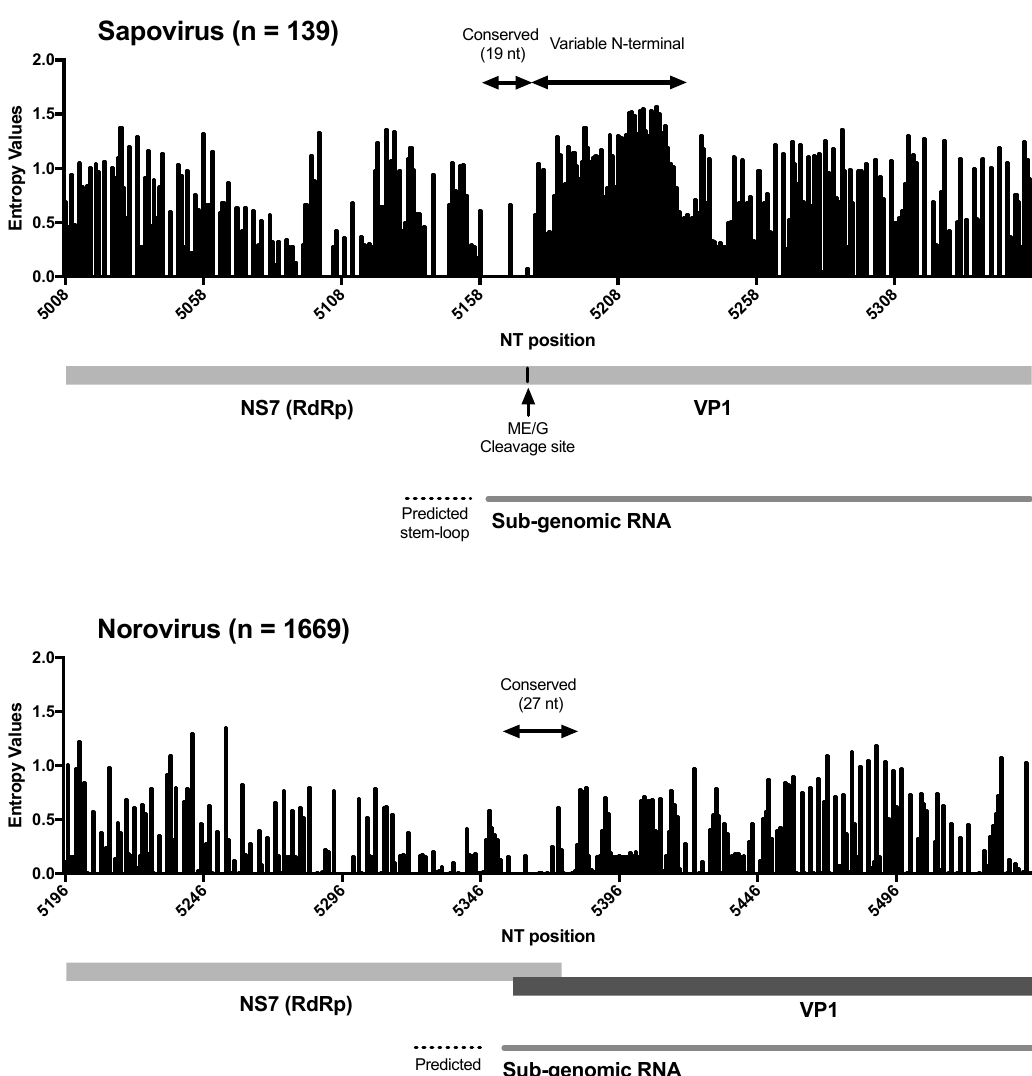
Figure 8. Variation at the RdRp-VP1 boundaries could explain limited recombination in human sapovirus. Shannon entropy values were calculated to quantify the nucleotide conservation for each site in the RdRp-VP1 boundaries. Sapovirus dataset includes human sapovirus GI, GII, GIV, and GV strains ( n = 139), and norovirus dataset includes human norovirus GI and GII strains ( n = 1669). Position of nucleotides was based on the multiple sequence alignments, including indels. Stem-loop sequences on predicted sub-genomic RNA promoter and sub-genomic RNA was determined based on analyses from Simmonds et al. [73]